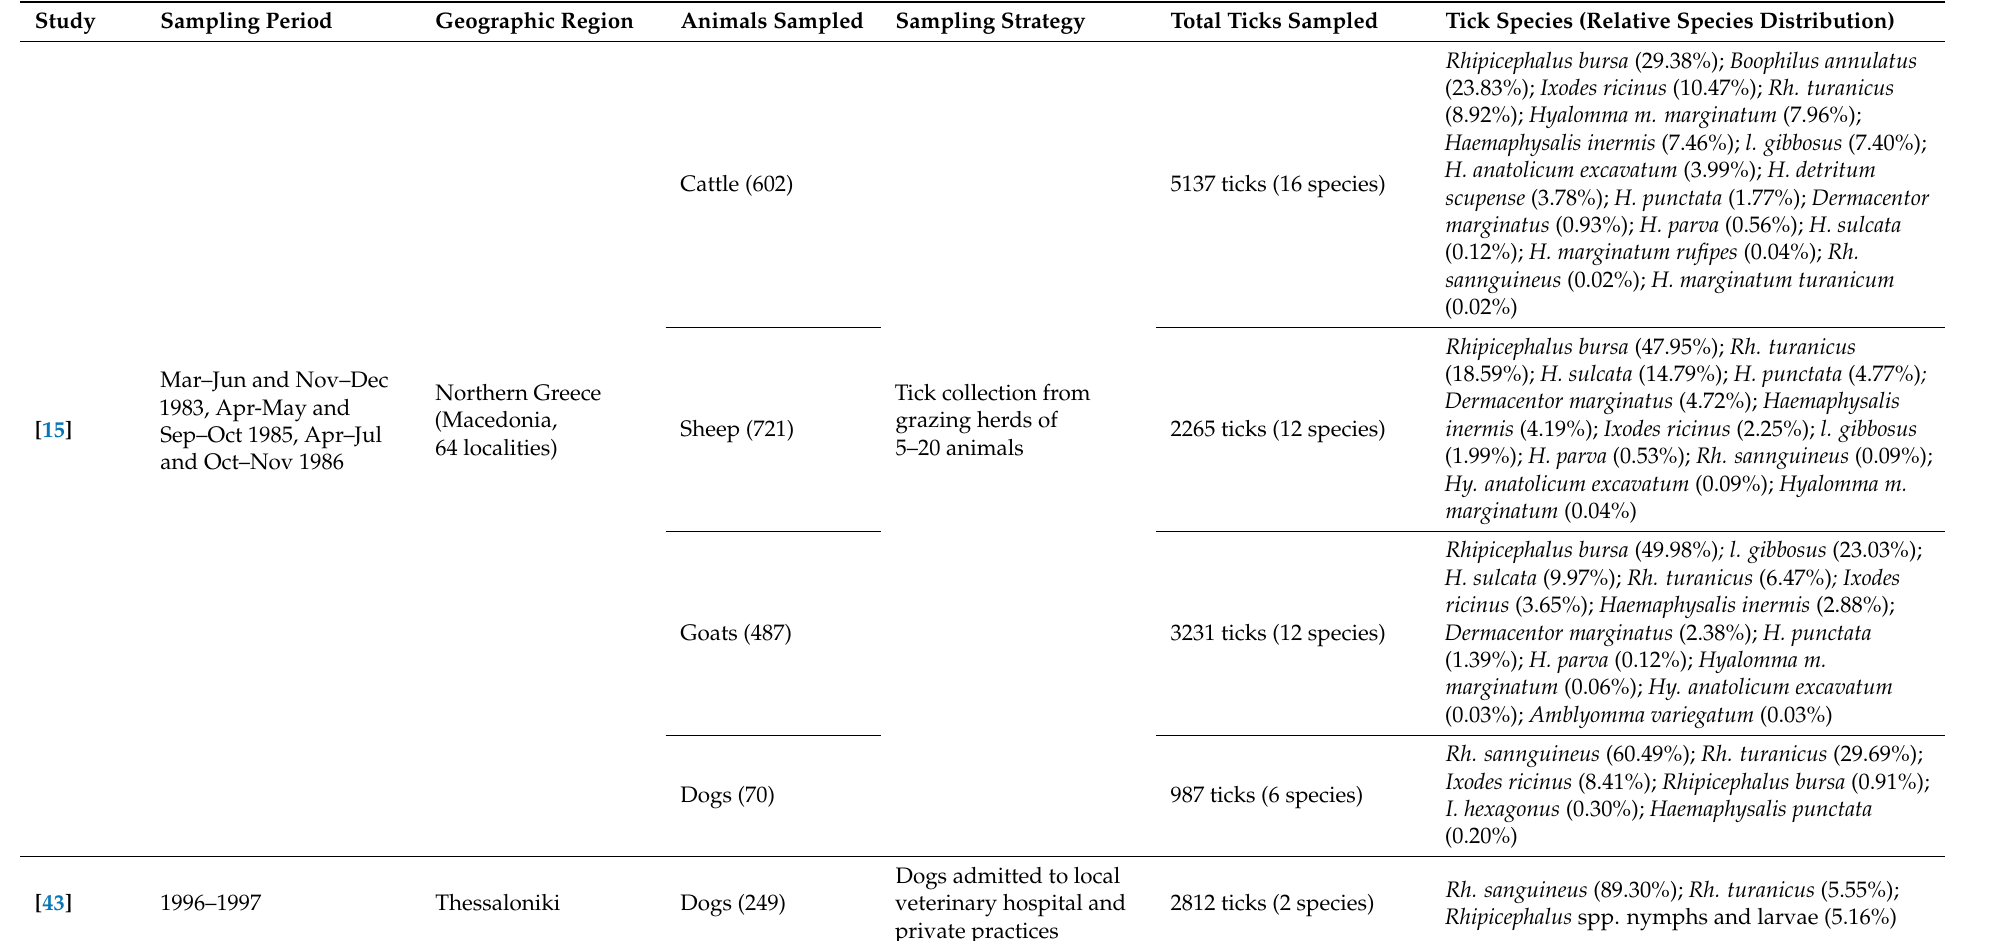
Table 2. Summary of the key findings of published studies on the prevalence of hard tick species parasitizing animals and/or humans in